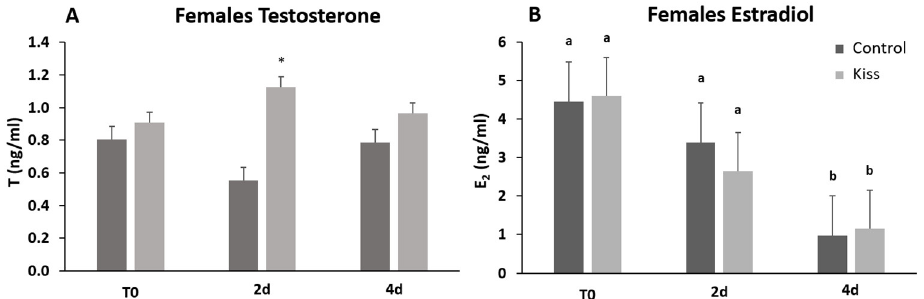
Figure 3. Sexual steroids plasma levels in ng / mL (mean ± SEM) from Senegalese sole females treated with kisspeptin hormone ( n = 15) and control ( n = 17). ( A ) Testosterone and ( B ) Estradiol levels before (T0) and after (2 h: 2-h; 4 h: 4-h; 2 d: 2-days; 4 d: 4-days) the kisspeptin injection. The asterisk denotes significant differences between experimental groups at each sampling point (Student’s t -test, p < 0.05); different letters indicate significant differences among sampling points within each experimental group (one-way ANOVA, Dunnett’s test, p < 0.05, T0 considered as control point).